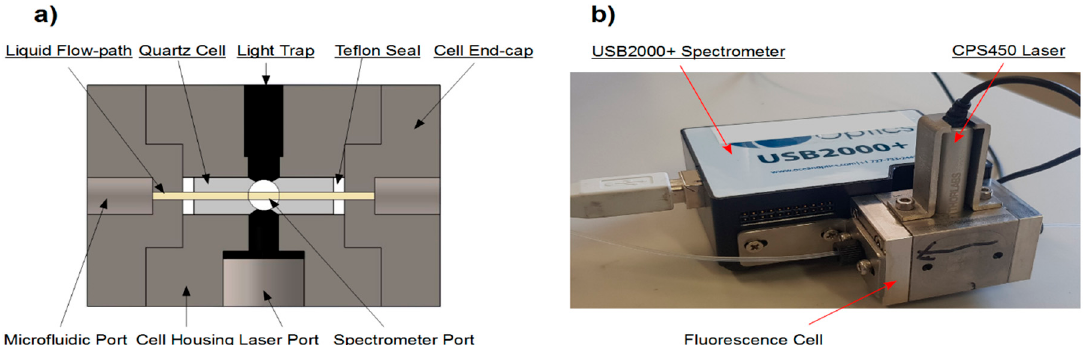
Figure 1. ( a ) Simplified cross-section of the microfluidic cell showing the assembly of key components. The cells outer dimensions are 30 × 30 × 48 mm. Notably, the liquid flow-path is a continuous cylinder throughout the entire illuminated path, significantly reducing the entrapment of bubbles inside the cell. ( b ) The assembly of the full fluorimeter illustrating the connections between the fluorescence cell, CPS450 laser and USB2000 + CPS450 laser and USB2000+ spectrometer.